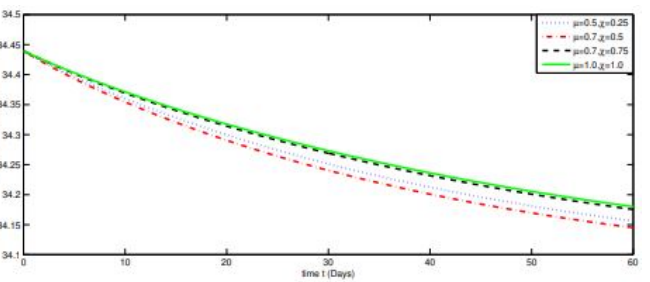
Figure 9. Graphs of numerical solutions at different fractal-fractional order for Susceptible class.